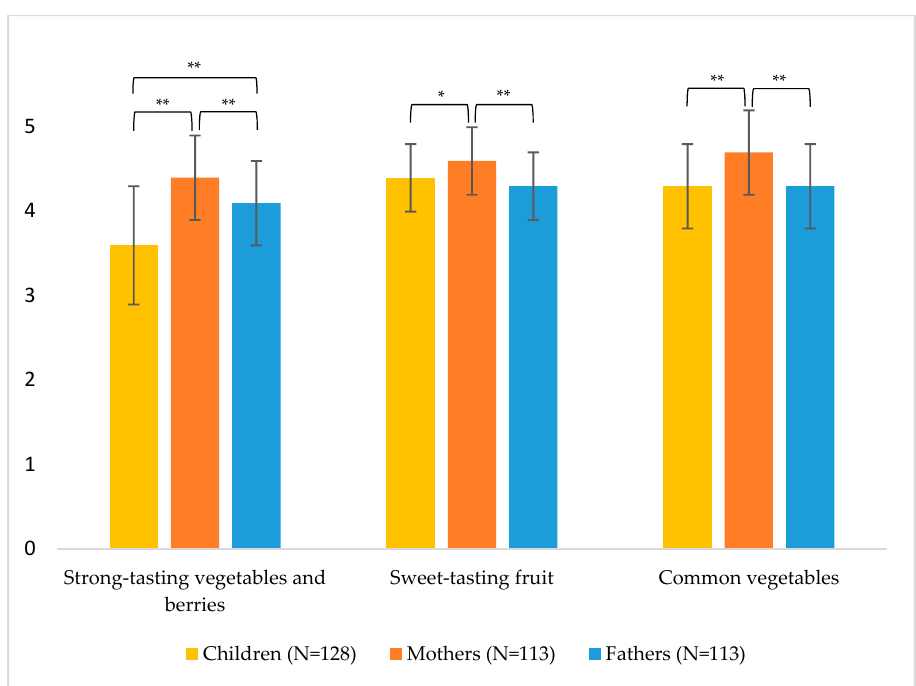
Figure 1. Results of the composite preference scores of 3–5-year-old children and their mothers and fathers (scale 1–5, 1 = I do/my child does not like this at all, 5 = I like/My child likes this a lot), mean and standard deviation. Significant differences shown * p < 0.01, ** p < 0.001 are based on the Wilcoxon signed rank test.